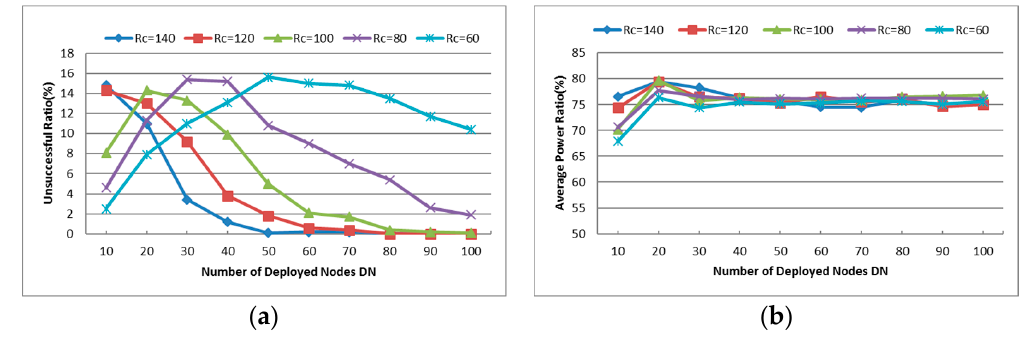
Figure 10. ( a ) UR with different R c and DN; and ( b ) PR with different R c and DN.